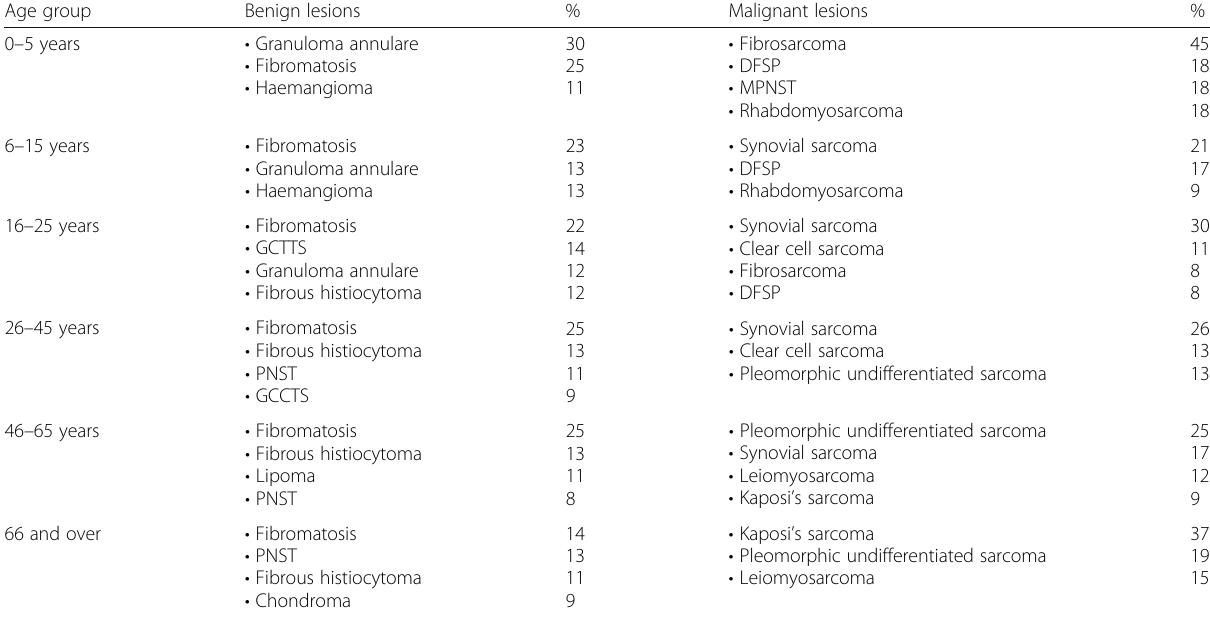
Table 1 Table showing the most common benign and malignant lesions of the foot and ankle subdivided by age group as described by Kransdorf [7,